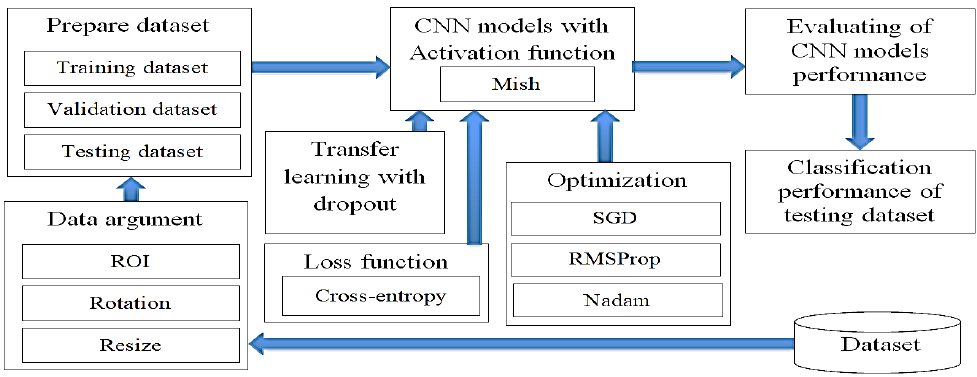
Figure 2. The research methodology.